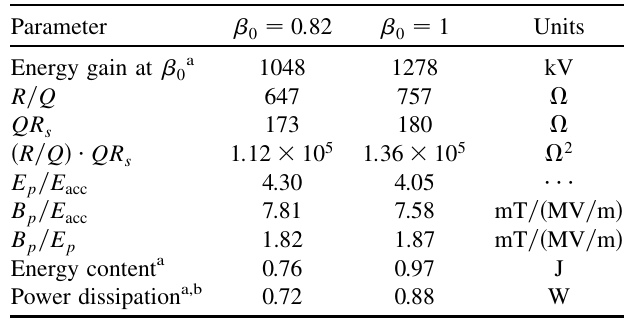
TABLE V. Radio-frequency properties, 352 MHz, (cid:1) 0 ¼ 0 : 82 and (cid:1) 0 ¼ 1 cavities optimized for higher shunt impedance. Parameter